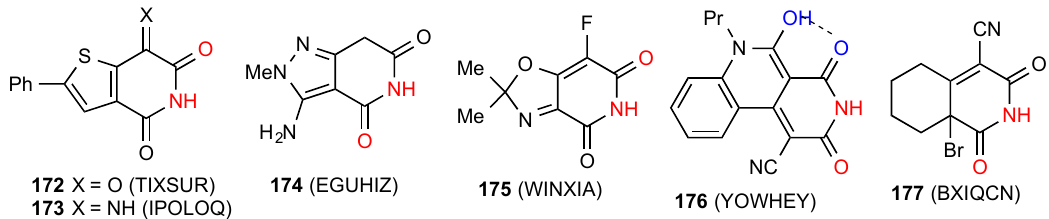
Figure 53. Ring-fused unsaturated glutarimides showing pattern A.